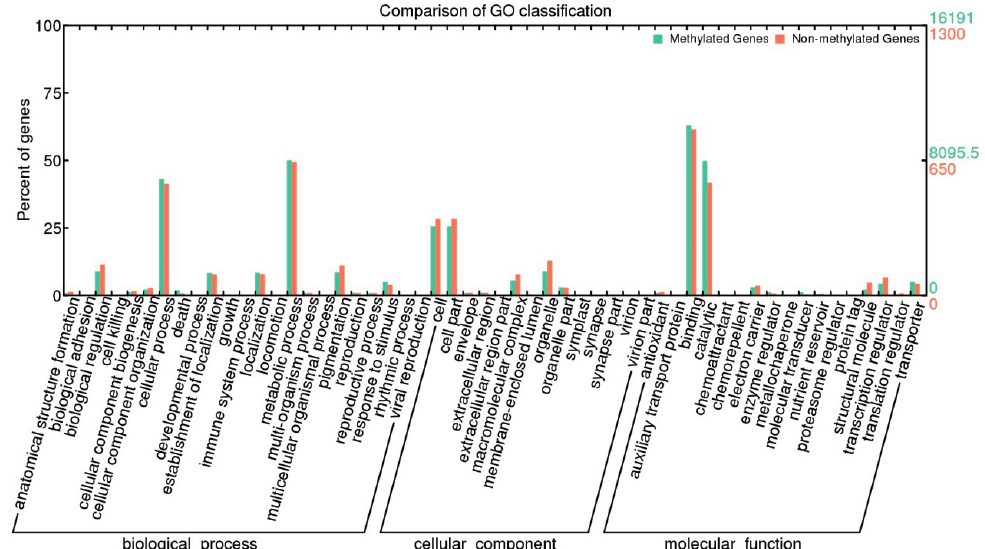
Figure 8. Analysis of methylated and unmethylated genes using WEGO (Web Gene Ontology Annotation Plotting) analysis. Annotations are grouped into the terms of cellular components, molecular function or biological process based on the Betula GO annotation information (unpublished). Gene numbers and percentages (on the log scale) are listed for each